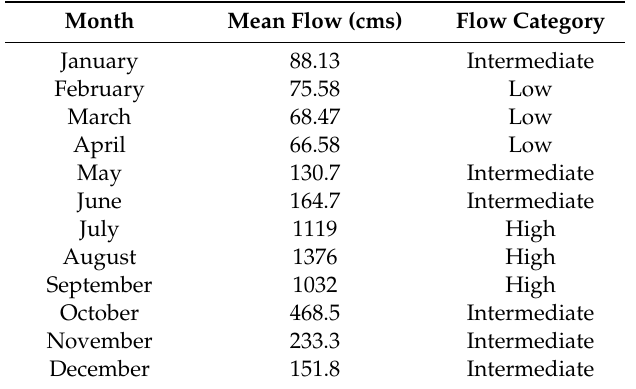
Table 1. Mean monthly flow and flow classification for the Kaligandaki